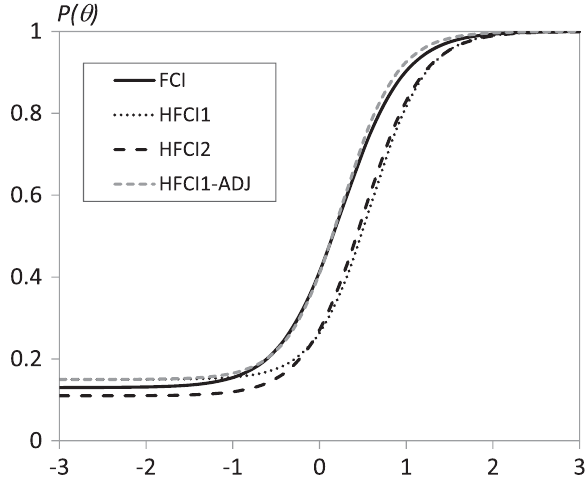
FIG. 1. IRT response curves of FCI and HFCI1. The horizontal axis represents the scale of the student ability parameter θ , which is typically between − 3 and þ 3 . The majority of students fall in the range of − 1 to þ 2 . The vertical dimension gives the probabilities of correct response (or the mean score) on the test of students with specific values of ability θ . The solid line plots the response curve of the FCI test based on the parameters in Table III. The black dotted and dashed lines plot the response curve of HFCI1 and HFCI2. The gray dashed line plots the response curve of HFCI1 with its difficulty parameter reduced by